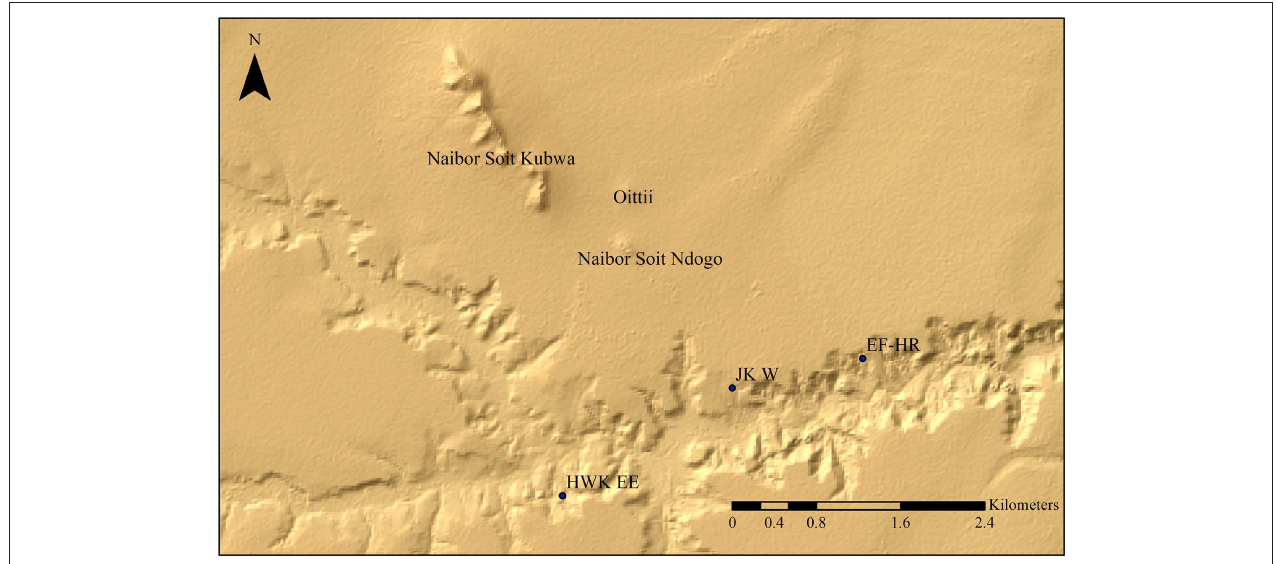
FIGURE 10 | Fuchsitic quartzites are unique to Naibor Soit Kubwa and Naibor Soit Ndogo (see Tables 2 , 3 ). Therefore, it can be inferred that green quartzite artifacts from HWK EE (Oldowan) (McHenry and de la Torre, 2018: Table 5), as well as EF-HR and JK W (Acheulean) (Leakey, 1994; McHenry and de la Torre, 2018: Table 5) were sourced from Naibor Soit Kubwa and/or Naibor Soit Ndogo. Sites after Hay